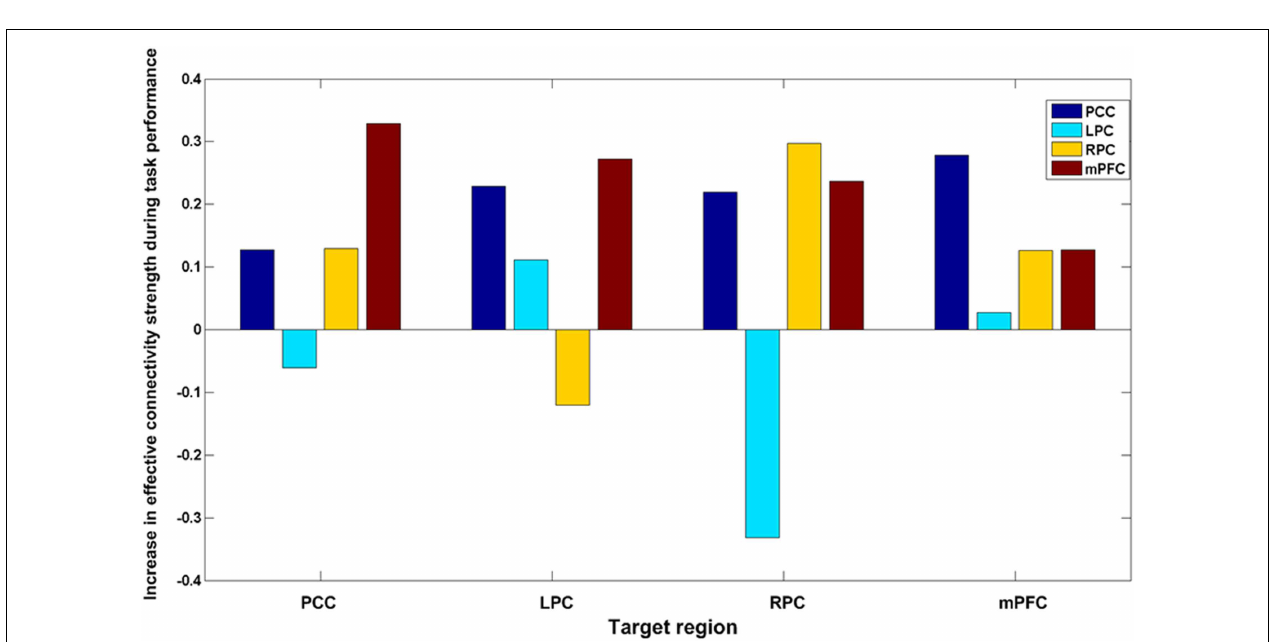
FIGURE 6 | Differences between the rest and task conditions for each of the 16 connections. Note that the majority have increased.